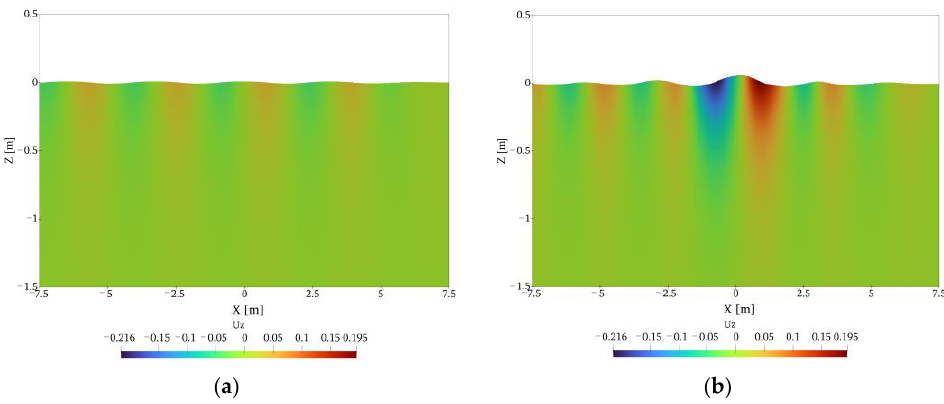
Figure 16. Z-velocity contours of water phase at y = 0 plane: ( a ) regular wave; ( b ) rogue wave.